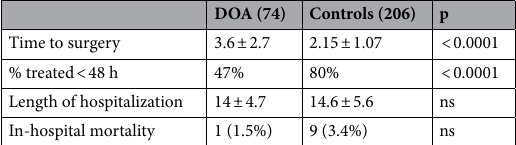
Table 3. Comparison of mortality rate and hospitalization between patients taking anticoagulants and controls.